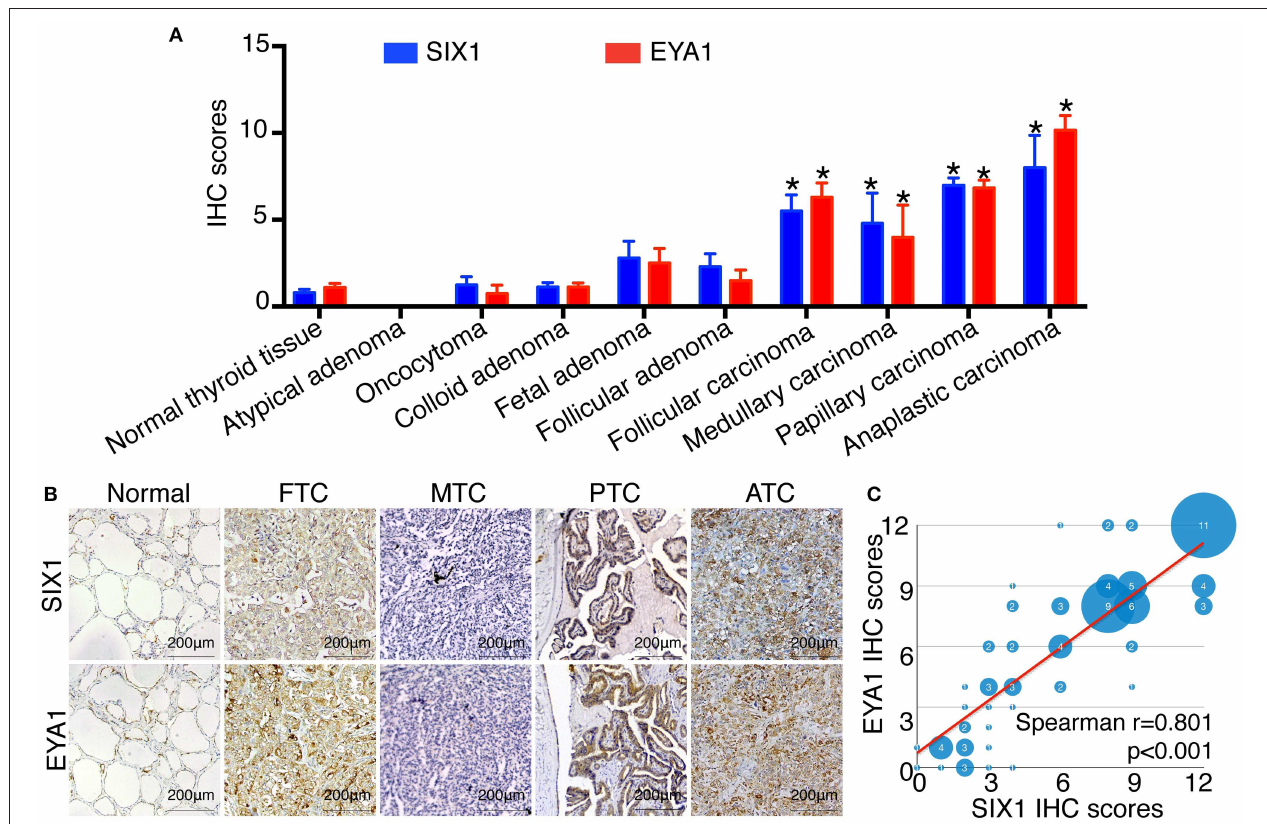
FIGURE 1 | The expression of SIX1 and EYA1 in PTC tissues. The semi quantitative results displayed as median ± stand error (A) . The relative expression of SIX1 and EYA1 in thyroid carcinoma tissue microarray, including normal thyroid tissue, atypical adenoma, oncocytoma, colloid adenoma, fetal adenoma, follicular adenoma, follicular carcinoma, medullary carcinoma, papillary carcinoma, and anaplastic carcinoma, *represents a statistical difference was found compared with normal tissue. (B) Representative immunohistochemistry images of SIX1 and EYA1 expression in normal thyroid, papillary thyroid carcinoma (PTC), follicular thyroid carcinoma (FTC), medullary thyroid carcinoma (MTC), and anaplastic thyroid cancer (ATC). (C) The positive relationship between SIX1 and EYA1 in thyroid malignant